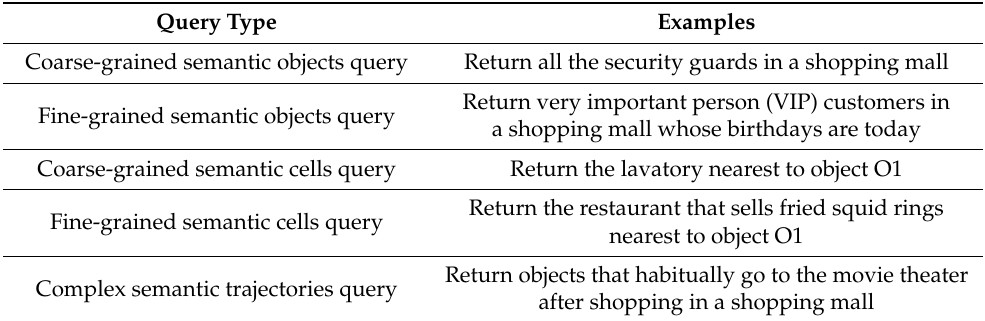
Table 3. Queries used in the experiments conducted in the present study.